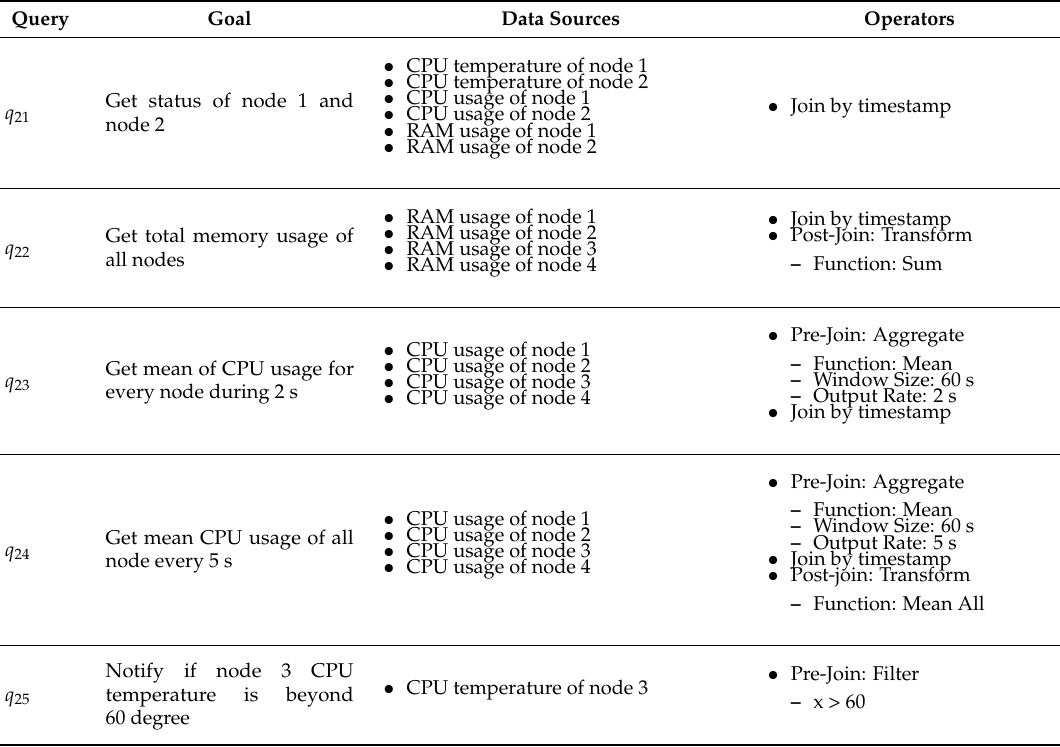
Figure 15. Hardware environment used for the IoT node system monitor. Table 3. List of queries for IoT node system monitor